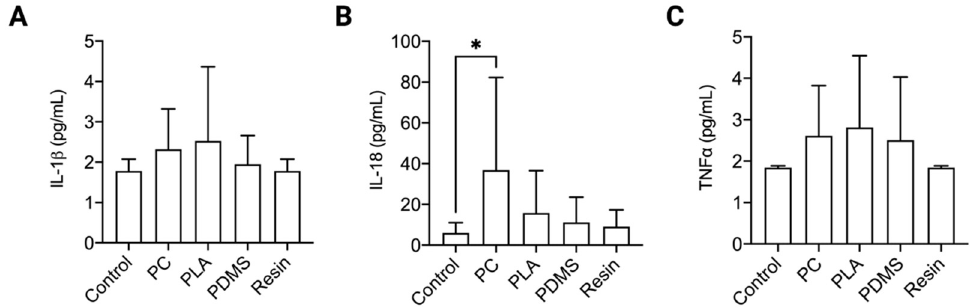
Figure 3. Pro-inflammatory cytokine levels. Figure shows the levels of ( A ) IL-1 β , ( B ) IL-18 and ( C ) TNF α released from THP-1 cells incubated for 24 h with PC, PLA, PDMS and resin. Data are presented as mean ± SD. Experiments were performed in at least 8 replicates. * indicates a p value ≤ 0.05.